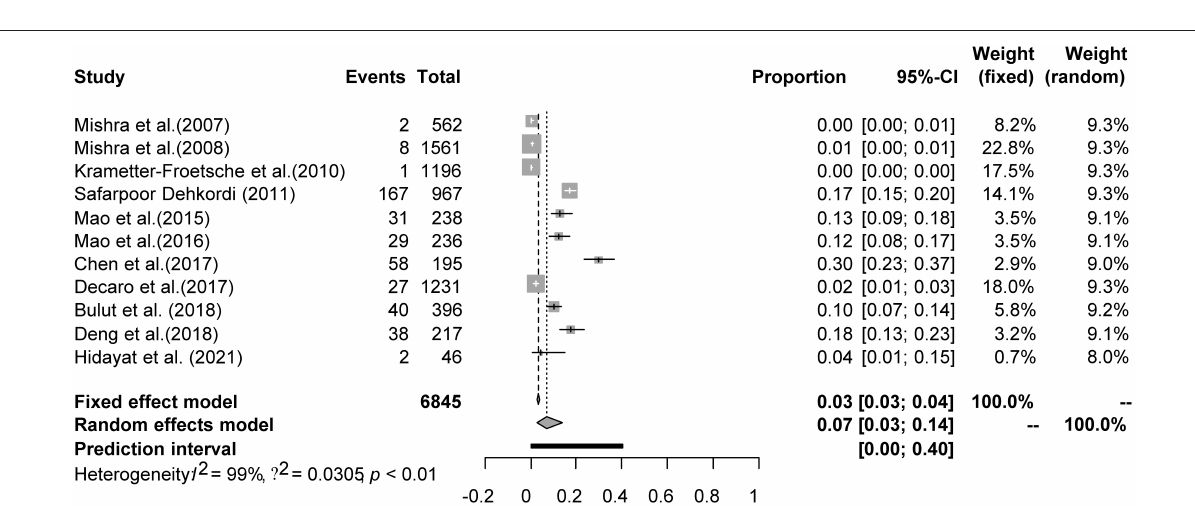
FIGURE 5 | Random-effects meta-analysis of BVDV infection in sheep and goats (Molecular methods).